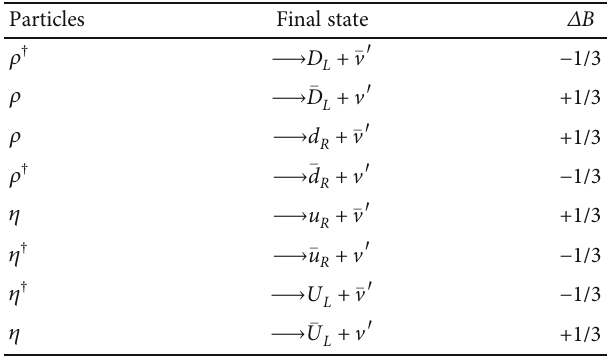
Table 2: The branching for decay processes of the leptoquark particles and their baryon number violations ( Δ B ).